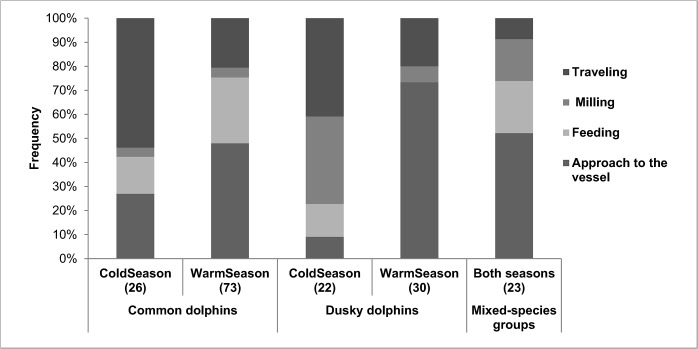
Predominant group activities.Percentages of occurrence of predominant group activities for common dolphins (Delphinus delphis), dusky dolphins (Lagenorhynchus obscurus) and mixed-species groups. Data were only obtained from systematic nautical surveys. The number in parentheses indicates the sample size.